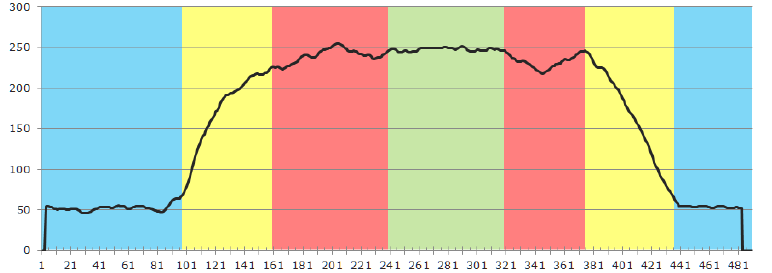
Figure 4. Exemplary intensity profile segmented into regions: (blue) background region, (yellow) transitional region, (red) artifact region, (green) measurement